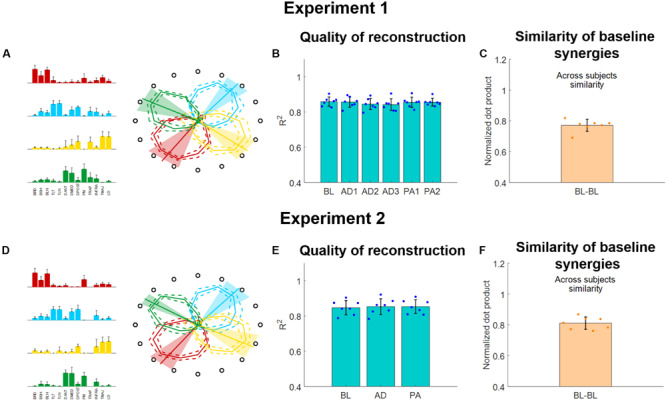
Muscle synergies extracted using the semi-fixed algorithm for both experiments. (A,D) Baseline synergy weights (average and standard deviations across subjects) and activation workspaces (represented by the irregular polygons, where each vertex of each polygon represents the RMS of the synergy for a given target, each represented by the hollow black circle). The preferred angles are also shown for each synergy as lines spanning from the center of the space (bold line represents the average across subjects, shaded areas represent the standard deviation). (B,E)
R2 of reconstruction for the synergies extracted from each block using the semi-fixed algorithm. Blue dots indicate the values of each individual subjects (averaged across macro-blocks), bars and whiskers indicate the average across subjects and the standard deviation. (C,F) Similarity of baseline synergies across subjects. Each dot represents the average similarity between one subject and all the other subjects. Bar and whiskers indicate the average across subjects and the standard deviation.